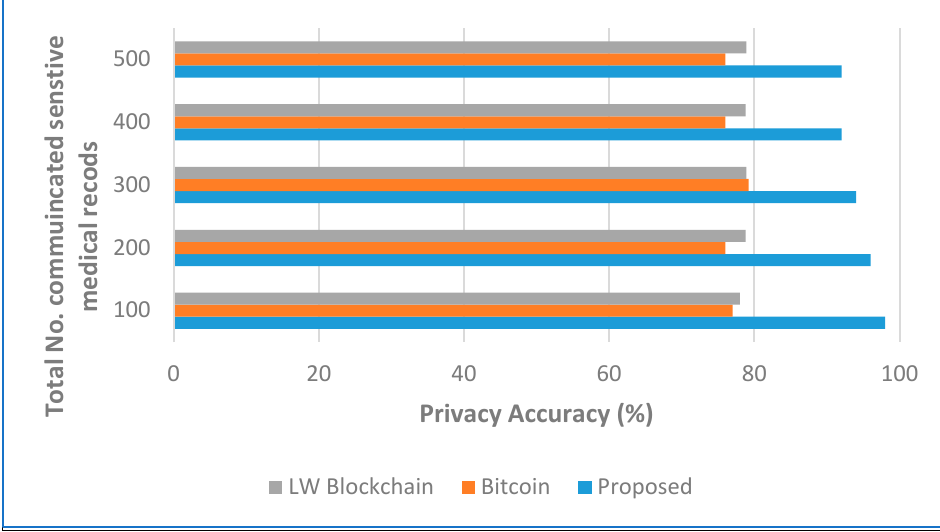
Figure 9. Privacy accuracy analysis when the number of medical records